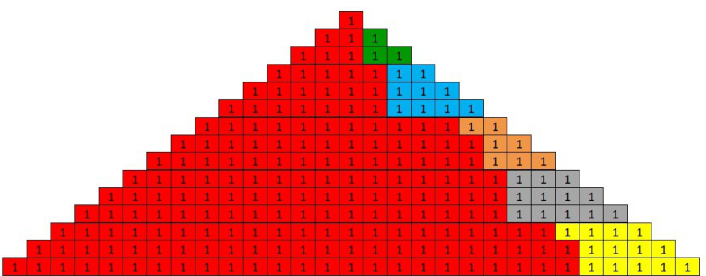
Figure 3. Need fulfillment degrees based on the experts’ opinions, using the aggregated average. Source: own study. The red color shows the need fulfillment degrees in terms of the security types, based on the hierarchy of needs concept proposed by Maslow. Blue color— social sphere of the energy market. Green color— environmental sphere of the energy market. Gray color— technological sphere of the energy market. Orange color— political sphere of the energy market. Yellow color— economical sphere of the energy market.